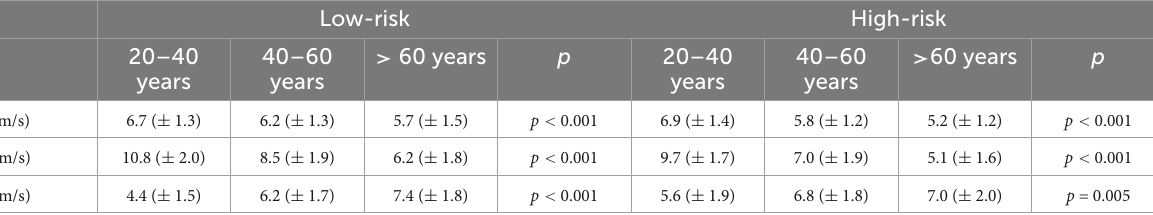
TABLE 2 Mean peak velocities by age